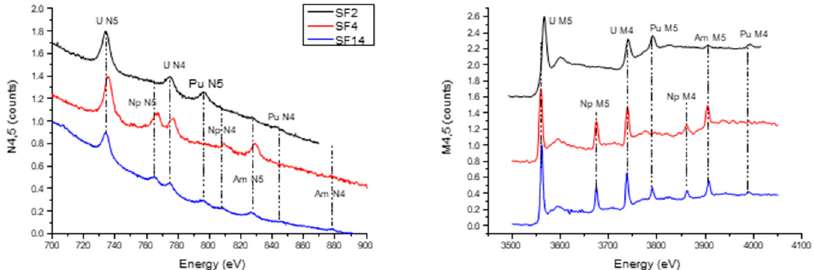
Figure A1. Different regions of the EELS spectrum for each SUPERFACT sample; the M 4,5 and N 4,5 edges (used for quantification) for each element are indicated.